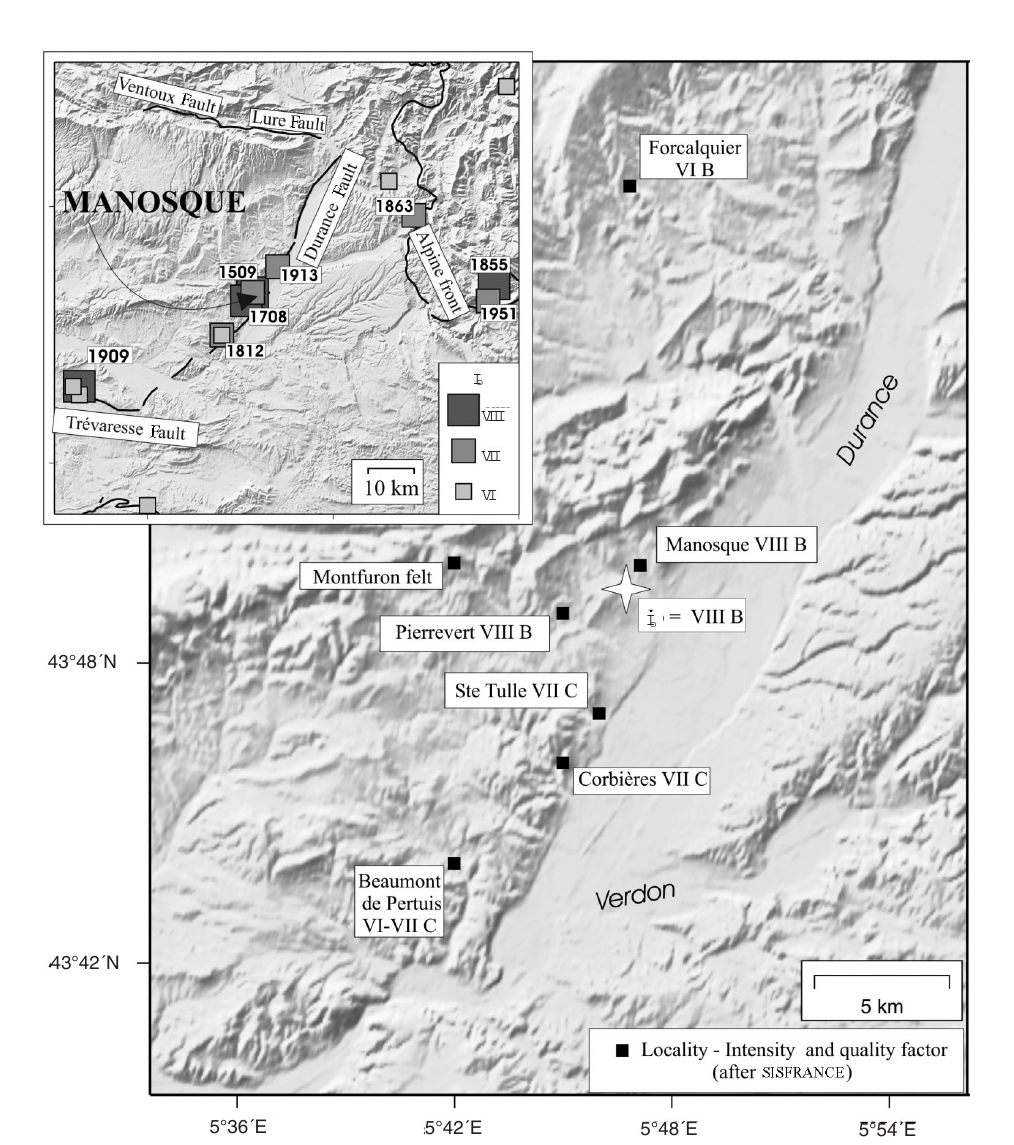
Fig. 1. Map showing estimated intensities for the 14 August 1708 Manosque earthquake taken from the SI - SFRANCE database. This event is only known on the basis of a few intensity points. The macroseismic epicentre (star) is located halfway between Manosque and Pierrevert with an epicentral intensity of VIII (fairly well con- strained). Inset: Historical seismicity ( I o ≥ VI) and the simplified fault map in the region of the 1708 Manosque earthquake. This region is characterized by a regular moderate seismicity that localizes along the Durance fault. The location of the 1909 Lambesc event on the Trévaresse Fault is also shown as well as the seismicity of the Alpine front to the